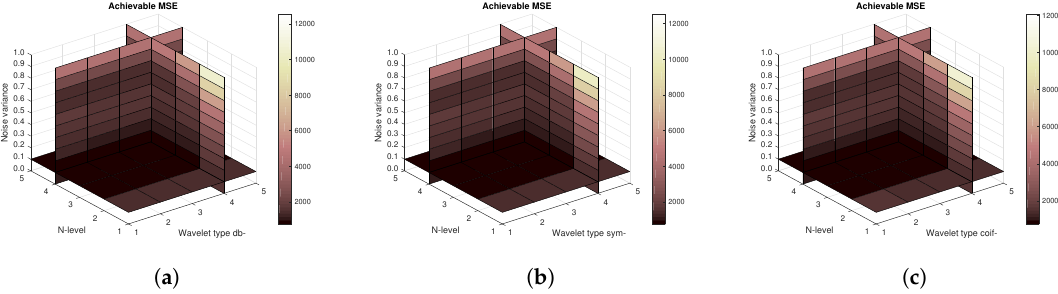
Figure 15. Mean achievable MSE values for 15 CT images from 5 patients with use of three mother wavelet families – from left Daubechies ( a ), Symlet ( b ) and Coiflet ( c ).